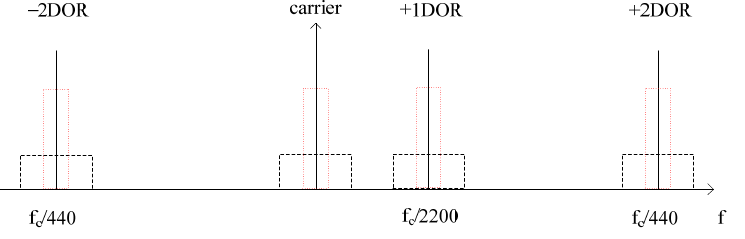
Figure 6. Channel configuration of DeltDOR measurement in cross support: the red frame means spacecraft scan and the black frame corresponds to quasar scan.